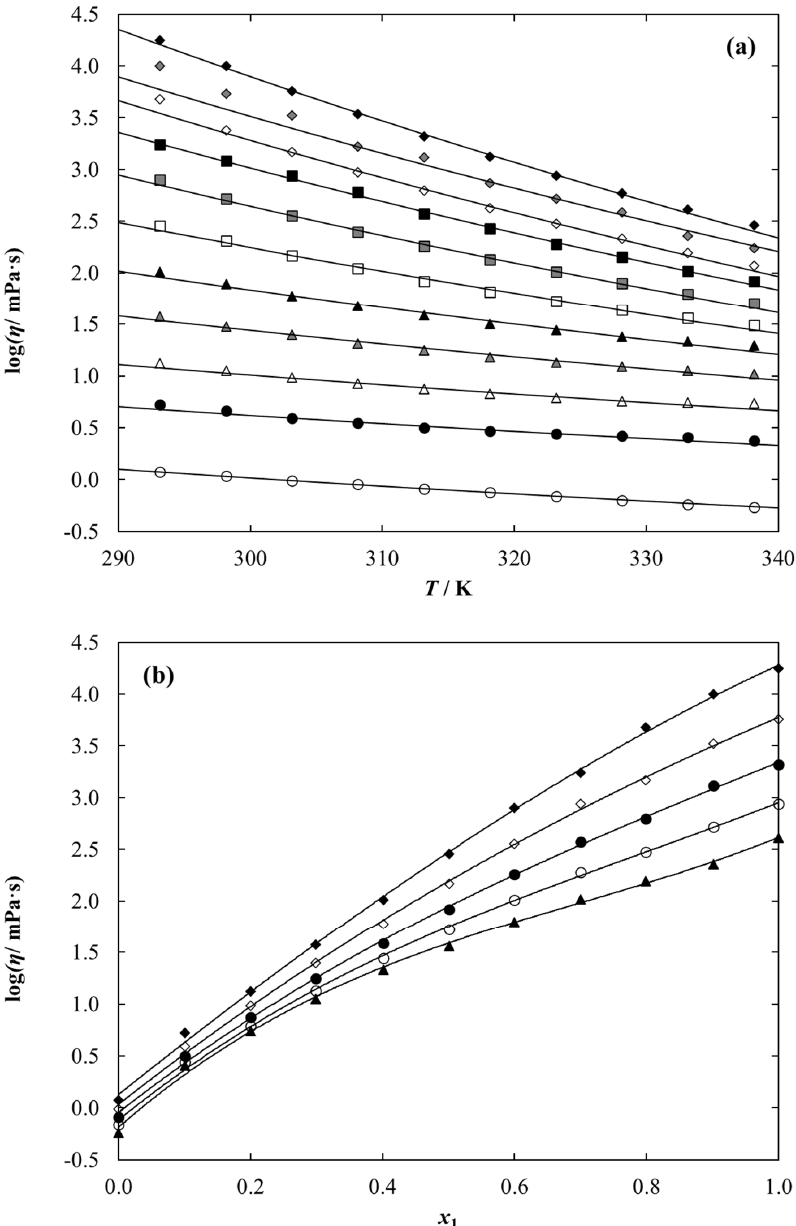
Figure 7. Experimental and calculated dynamic viscosity data for {[C1C2MOR][DMP] (1) + Ethanol (2)} binary system as a function of ( a ) temperature for different IL mole fraction, x 1 : ♦ , 1.0000; ♦ , 0.9012; ◊ , 0.7990; ■ , 0.6997; ■ , 0.5994; □ , 0.5012; ▲ , 0.4012; ▲ , 0.2991; Δ , 0.2005; ● , 0.1001; ○ , 0.0000. Points ‐ experimental data; solid lines ‐ correlation using equation (19) with parameters given in Table 12. ( b ) Composition at different temperature, T: ♦ , 293.15 K; ◊ , 303.15 K; ● , 313.15 K; ○ , 323.15 K; ▲ , 333.15 K. Points ‐ experimental data; solid lines ‐ guide to the eye.